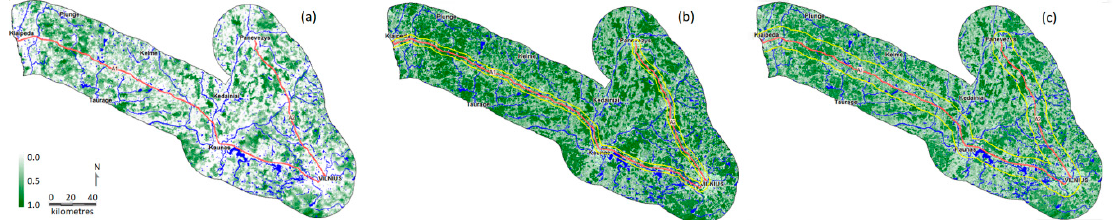
Figure 3. Map of modeled habitat suitability (range 0–1, where 1 is most suitable habitat) for red deer ( a ), roe deer ( b ) and wild boar ( c ) in 2007 around the highways A1 and A2 in Lithuania. Buffer size: 20 km for red deer, 3 km for roe deer and 8 km for wild boar, both shown by yellow lines. Note that the broad distribution of relatively good habitat for roe deer corresponds well with the ubiquitous nature and high adaptability of this species.